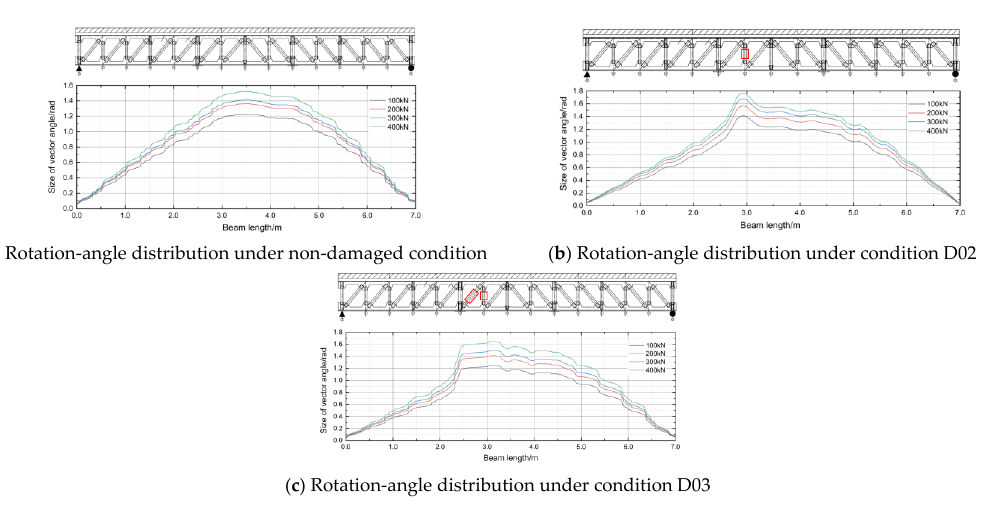
Figure 31. Upper chord steel plate edge’s rotation-angle distribution under conditions D01 – D03. Subsequently, the K value for the two damage conditions was calculated, as shown in Figure 32.